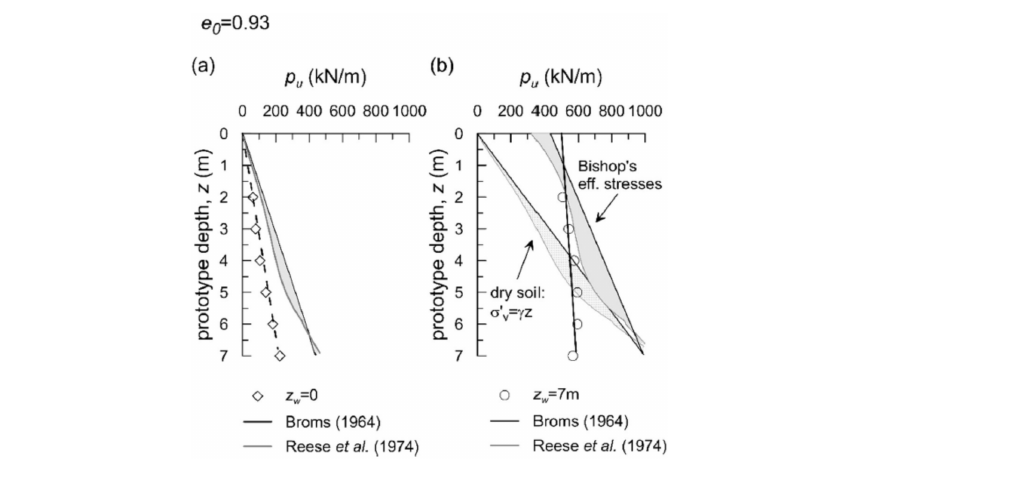
Figure 14. Profiles with depth of p u (limiting pressure), prediction versus literature solution: ( a ) saturated soil conditions (LS), ( b ) unsaturated soil conditions (LU). As may be expected, for the saturated soil the distributions of K and p u linearly